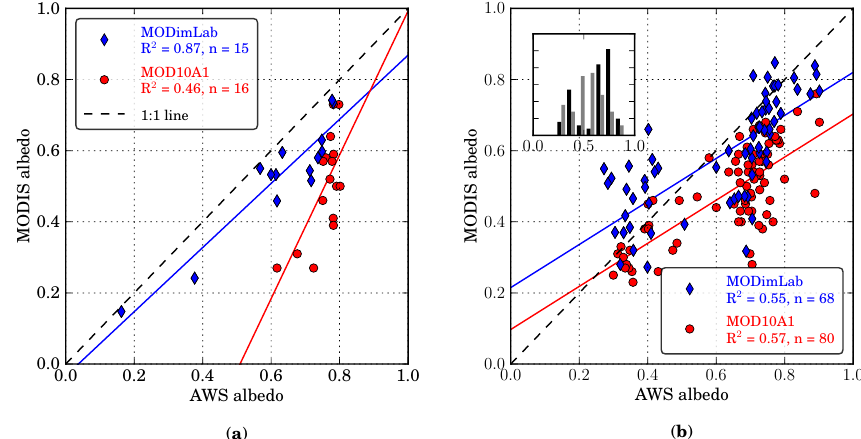
Figure 5. Measured albedo vs. MODIS-retrieved albedo for Chhota Shigri Glacier (a) and Mera Glacier (b) . For Mera Glacier RMSE are 0.10 and 0.08 for the MODImLab and the MOD10, respectively. Please note that the number of MOD10 and MODImLab images is different because the two data set are filtered with different cloud detection algorithms. The inset represents the distribution of the measured albedo (grey = satellite, black = AWS).